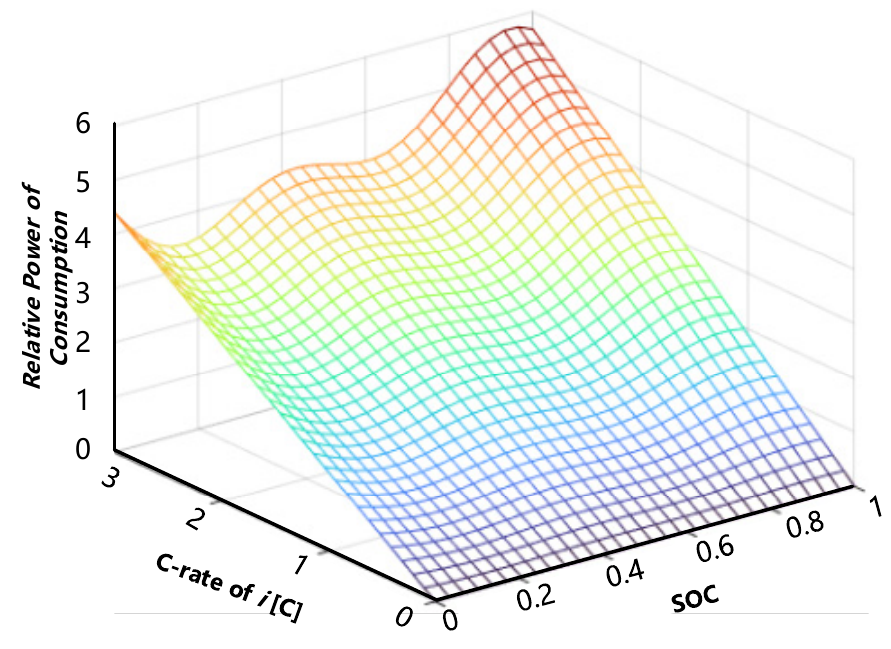
Figure 7. Power of consumption curve as a function of i and SOC. C-rate: normalized current against the current capacity of the battery.